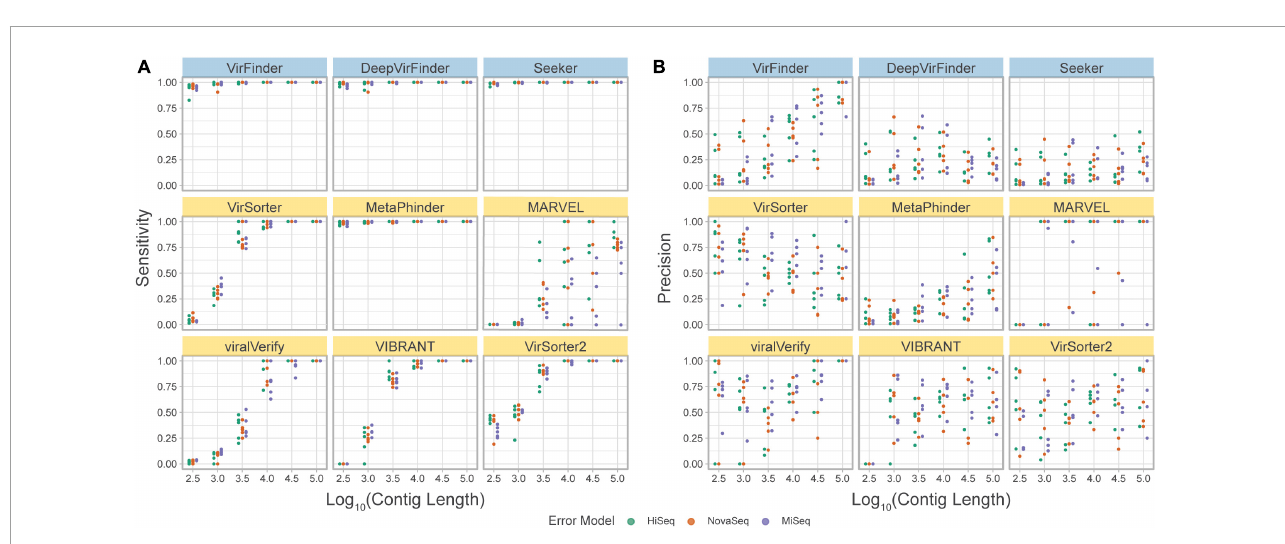
FIGURE7 (A) Precision and (B) sensitivity on a simulated metagenome dataset. Each point represents the tool’s performance on contigs within a given length group, assembled from reads from a specific abundance profile, using the indicated error model. Top row of tools are sequence-based (in blue), bottom two rows are homology-based (in